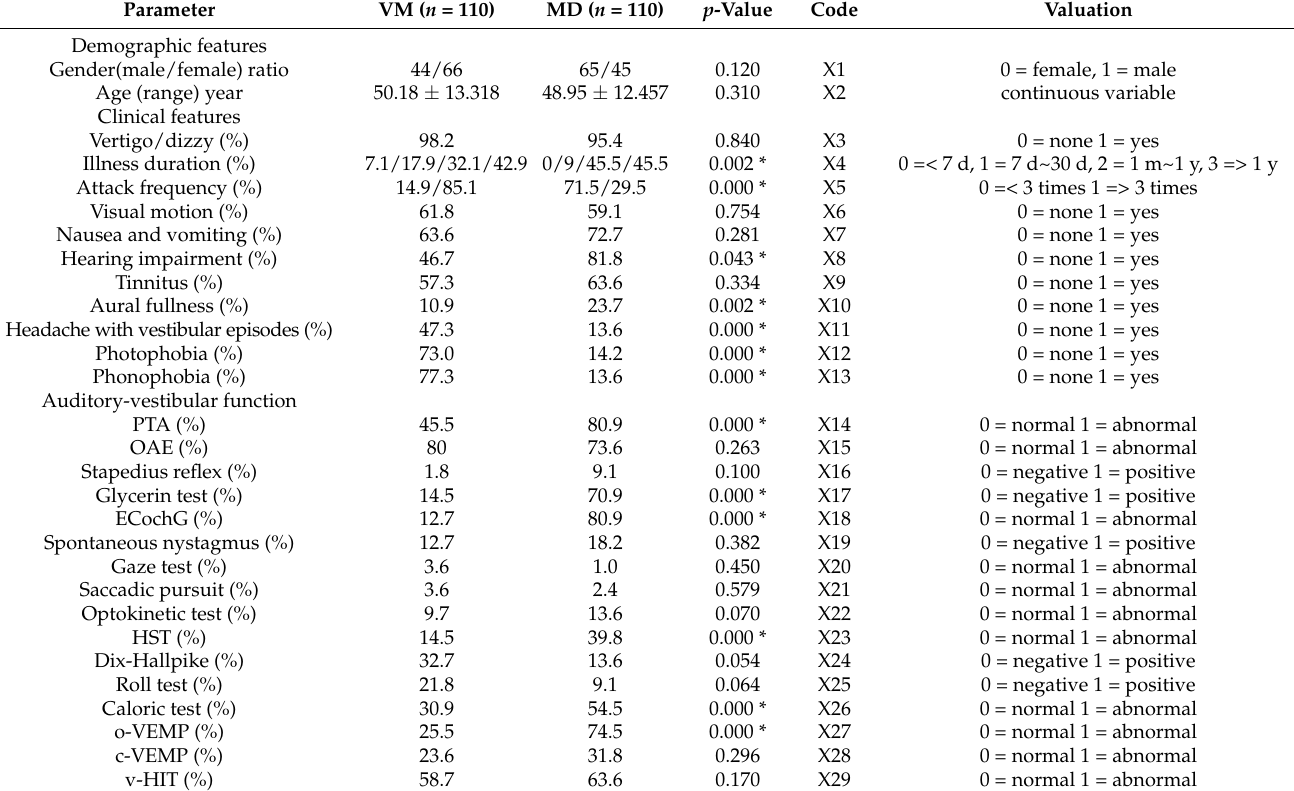
continuous variable